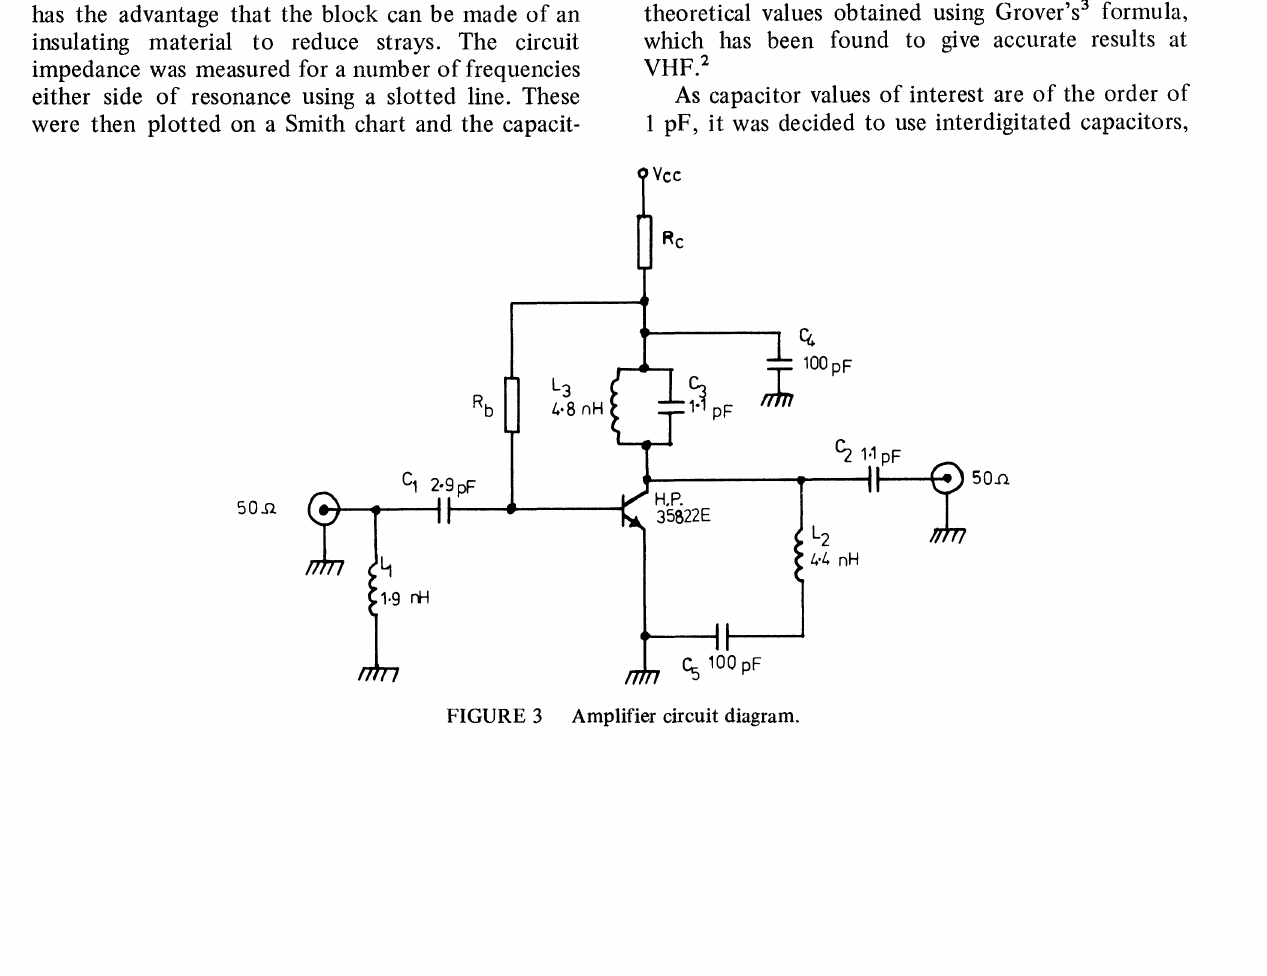
o Relation between inductance, outside diameter and track width, for single loop inductors.